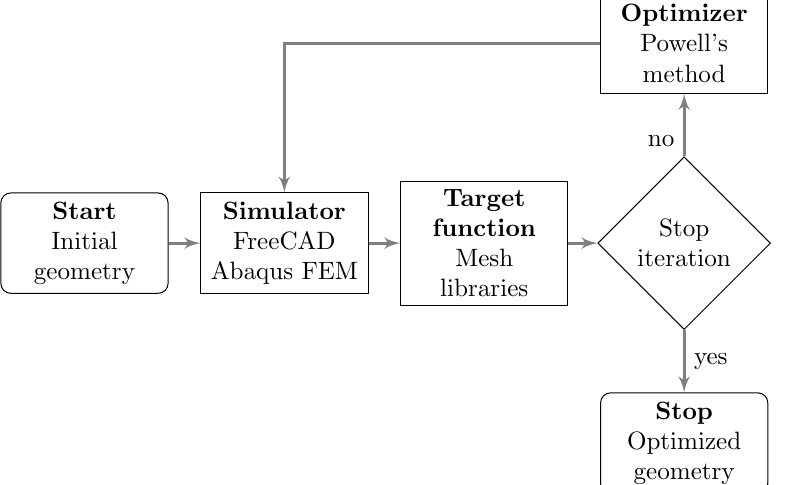
Figure 1. Optimization procedure and software components. From the initial geometry parameters (i.e., a set number of control points), the simulator generates a CAD model, meshes and deforms it. The target function evaluator utilizes mesh libraries to estimate the target function value from the deformed mesh provided by the simulator. In each iteration of the optimization, the optimizer selects new geometry parameters for the simulator.